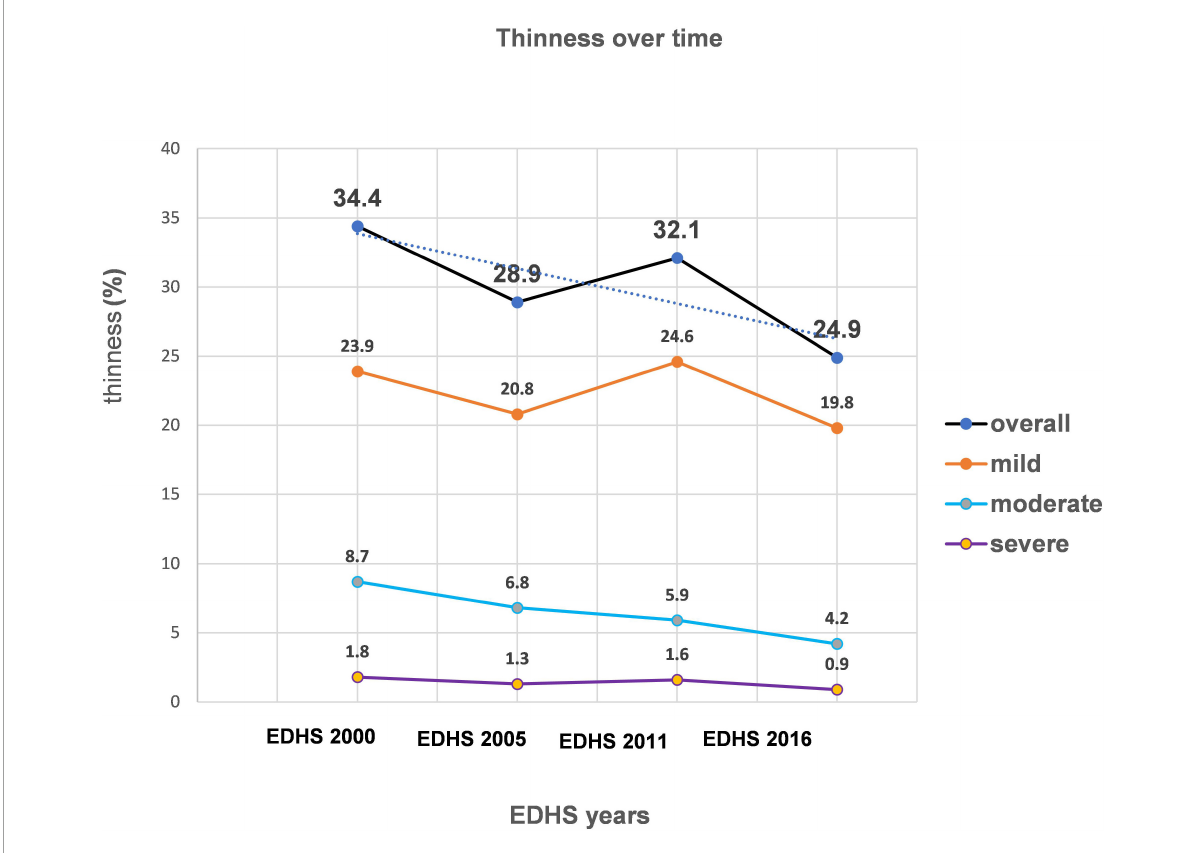
FIGURE1 Trends of thinness among late adolescent girls in Ethiopia from EDHS 2000 to